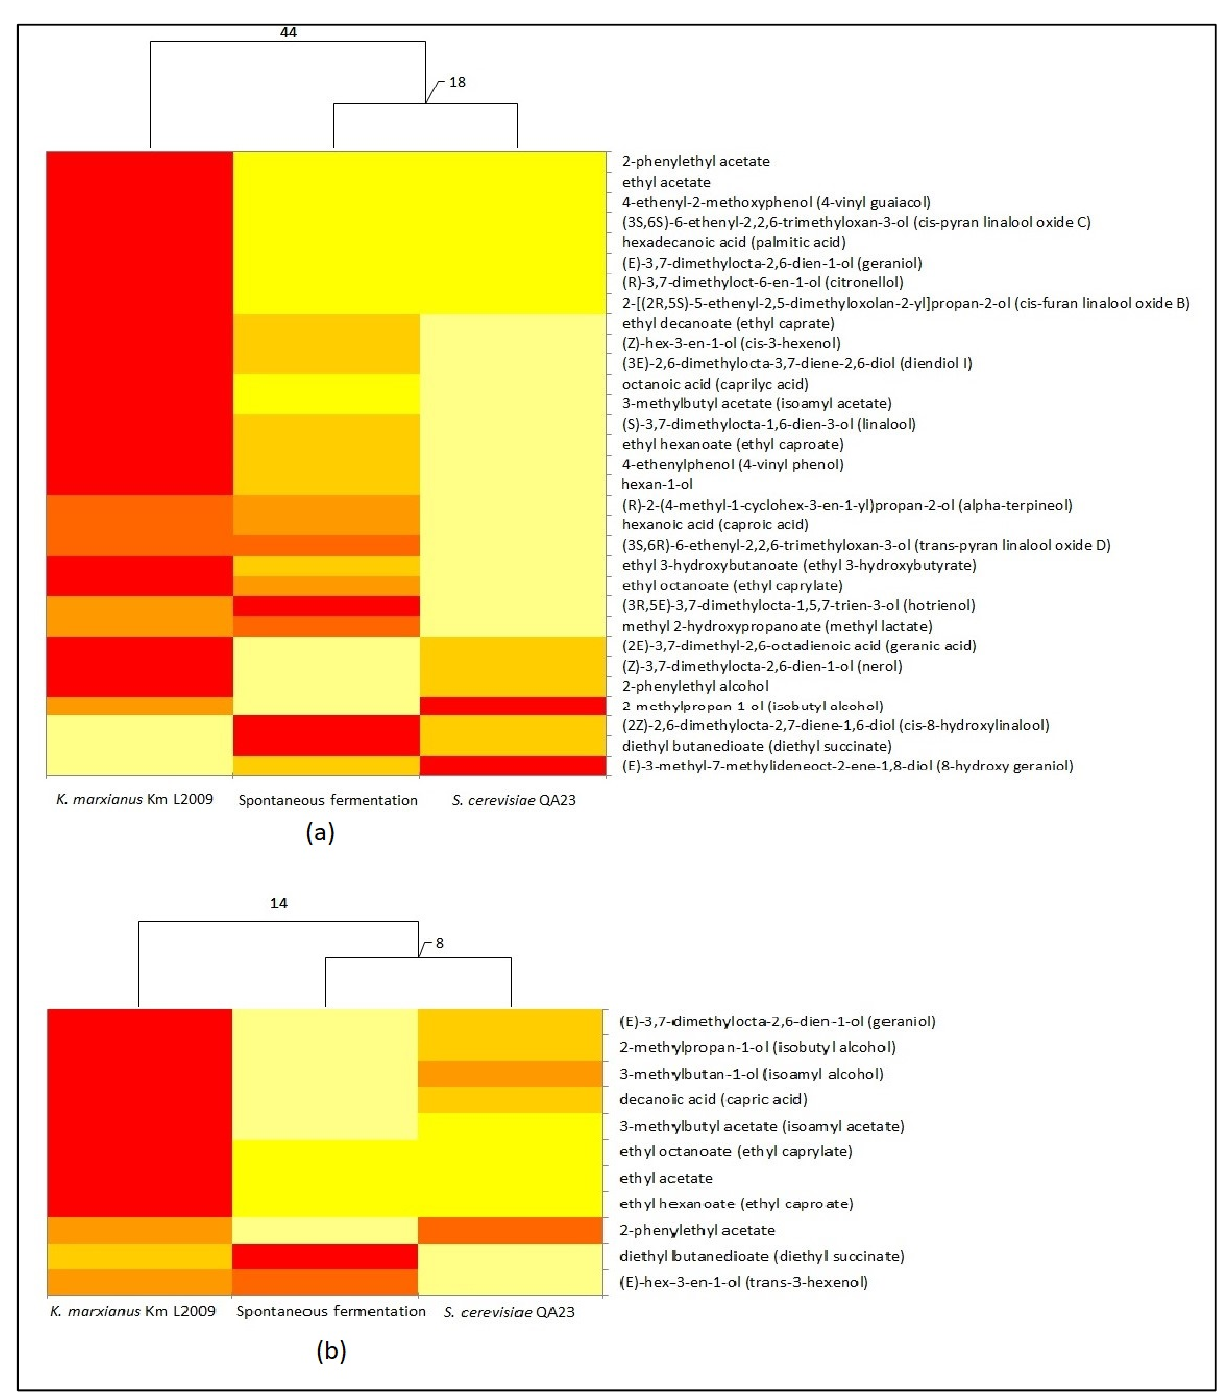
Figure 6. VOC distribution in different Muscat of Alexandria ( a ) and Grillo ( b ) wines. Dendrograms are based only on VOCs, respectively of Table 4 and Table 5, showing concentrations with statistically significant differences. The heat maps depict the relative quantity of each VOC (variables clustering on X-axis) within each type of vinification (Y-axis clustering). The values for VOC concentrations are depicted by color intensity from light yellow (lowest concentration) to red (highest concentration). Numbers indicate the distances between the clustered columns calculated as Euclidean dis- tances.